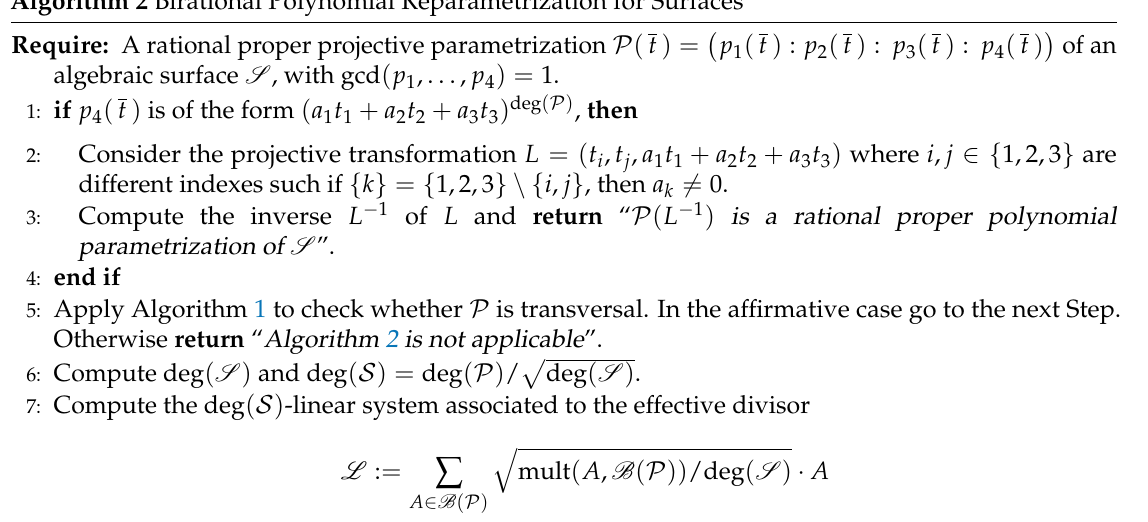
Algorithm 2 Birational Polynomial Reparametrization for